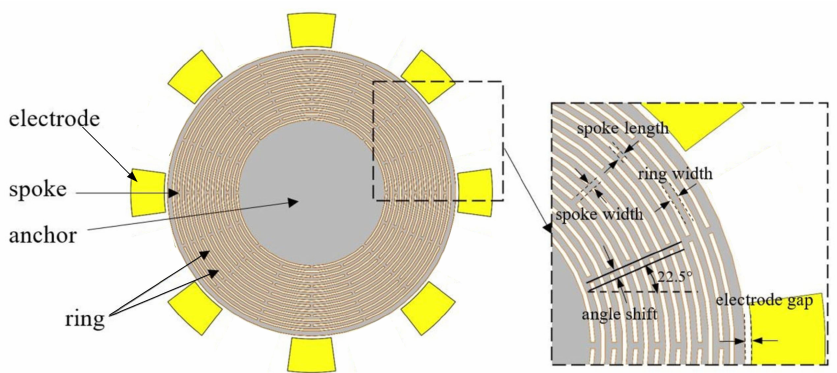
Figure 11. Structure of the disk resonator